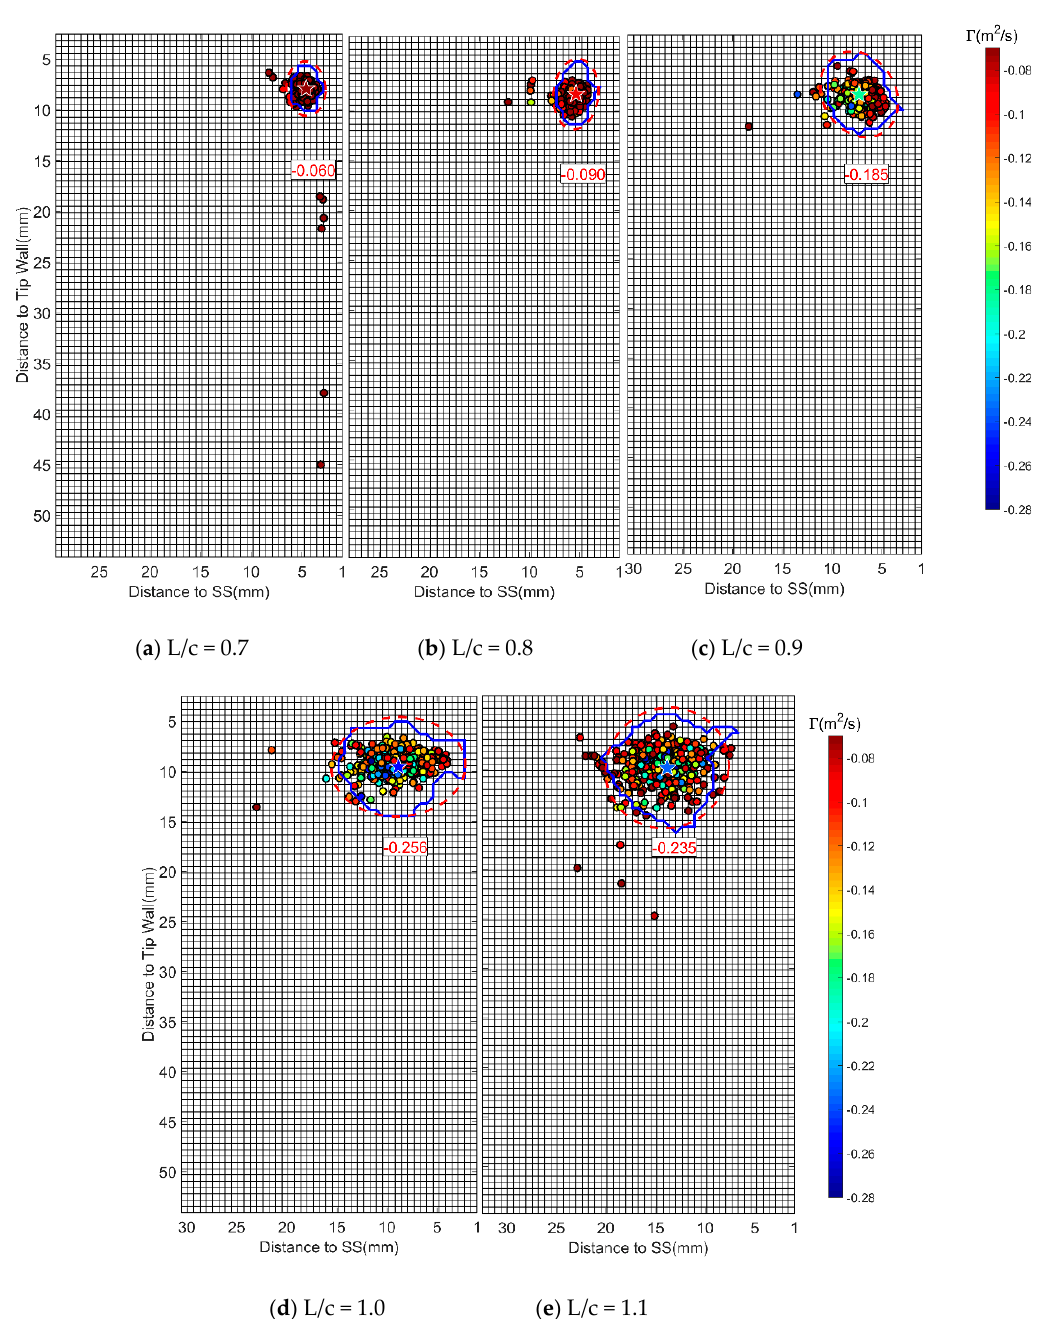
Figure 10. Statistical distribution of the locations, area and circulation of identified TLV cores. The color of the points shows the vortex circulation.